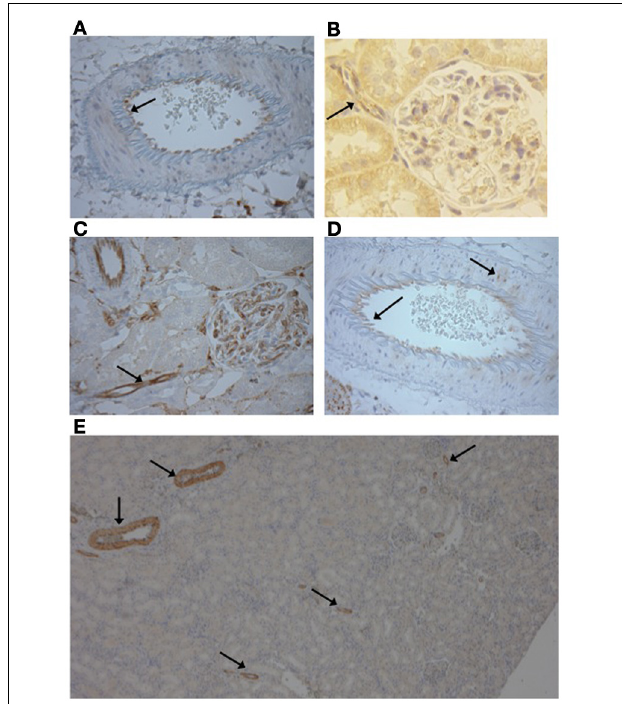
FIGURE 4 | (A) Vascular P2X 4 receptors were expressed in the endothelium (Image from F344 rat × 400) and (B) the afferent arteriole (Image Lewis rat × 500). (C) P2X 7 receptors were stained in the endothelium of the preglomerular vasculature, including the afferent arteriole (arrow) and cells of the glomerulus (Image F344 rat, × 400). (D) Occasional smooth muscle staining of P2X 7 was observed (arrow; Lewis rat, × 400). (E) P2X 1 immunopositive staining was only observed in the vasculature and was limited to the smooth muscle layer of large and small diameter vessels (F344 rat, × 50).